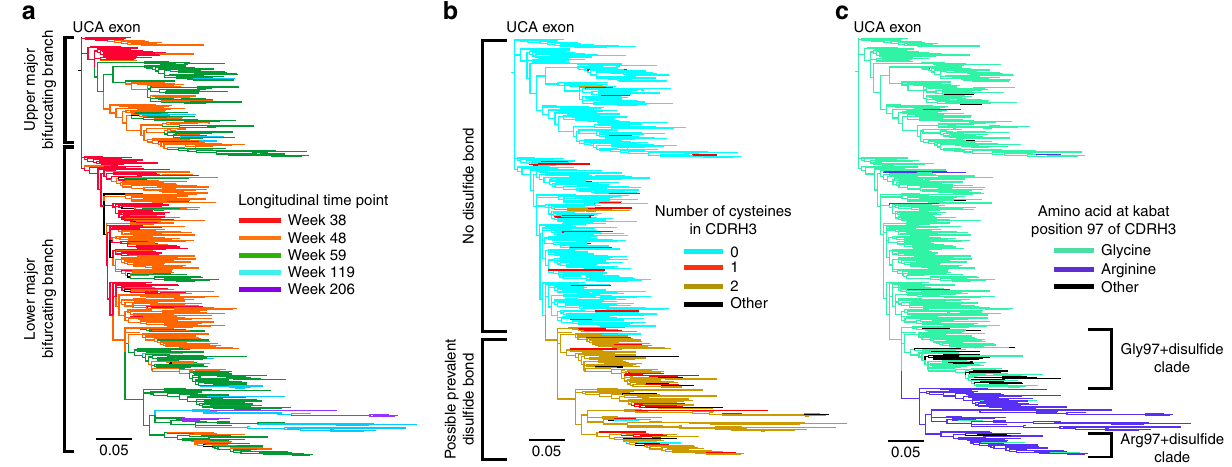
Fig. 2 Critical CDRH3-stabilizing mutations of the VRC26 lineage. a The V H exon ML tree with sequences highlighted by the longitudinal time point at which they were isolated. b The V H exon ML tree showing the number of cysteines in the CDRH3. c Same as in b but colored with respect to the amino acid at CDRH3 Kabat position 97